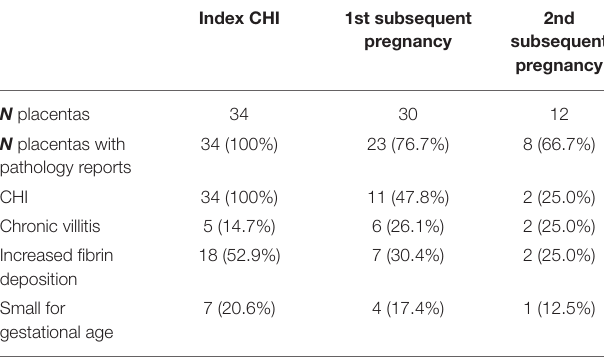
TABLE 3 | Histopathology of placentas from index and subsequent pregnancies in women with chronic histiocytic intervillositis